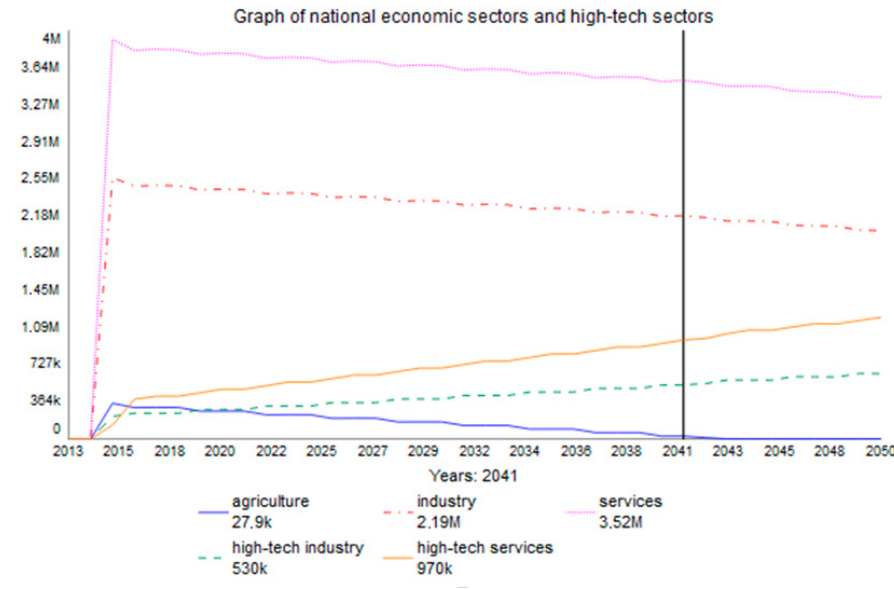
Figure 3. National economic sectors and high-tech sectors (year 2041—prediction).